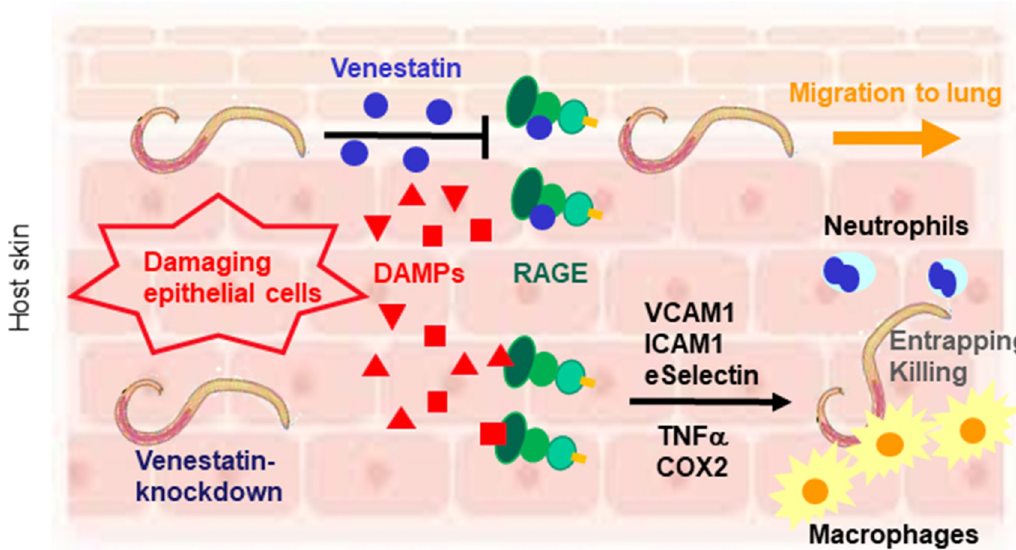
Fig 10. Schematic diagram showing the roles of venestatin during larval migration of the nematode S . venezuelensis . As RAGE ligands, damage-associated molecular patterns (DAMPs) are released from damaging skin tissues by invasion of S . venezuelensis larvae and then bind to RAGE. RAGE signaling induces the expression of cytokines and adhesion molecules, resulting in recruitment of macrophages and neutrophils to entrap or kill venestatin-knockdown larvae. Venestatin downregulates inflammatory responses to control larval invasion. Venestatin may prevent binding between DAMPs and RAGE. Consequentially, larvae secreting venestatin migrate to the lung.